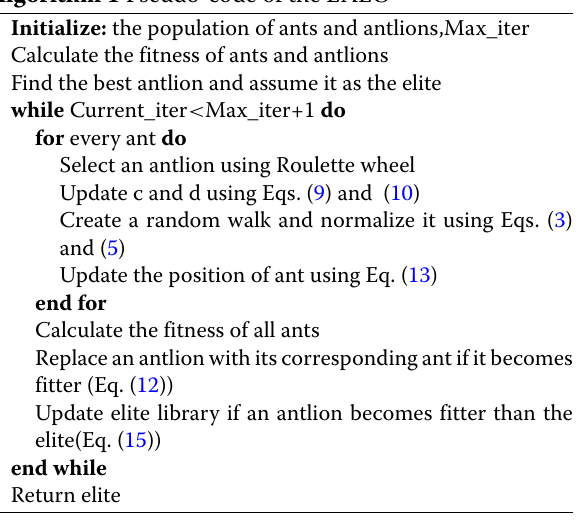
Algorithm 1 Pseudo-code of the